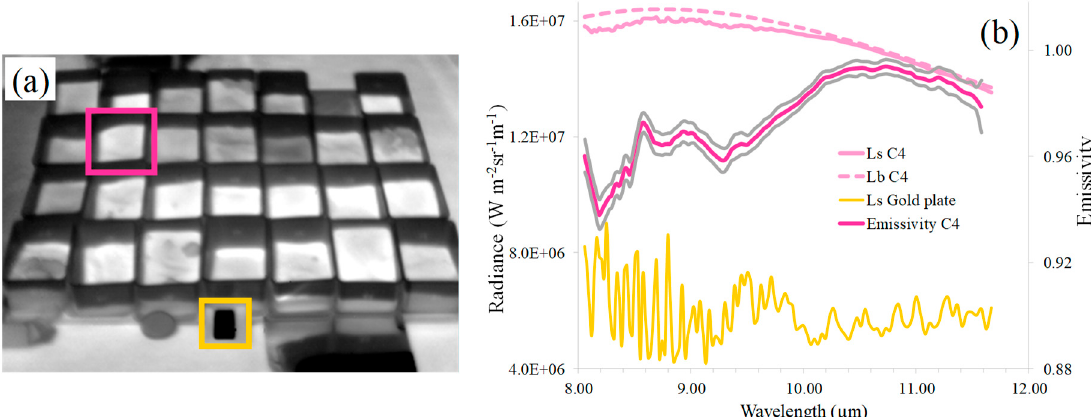
Figure 1. ( a ) Longwave infrared (LWIR) image (band 10.62 µm) of soil samples (each placed in a 17 × 17 × 22 cm box); soil C4 (pink square), and gold plate (yellow square). ( b ) At-sensor radiance (solid pink curve) and fitted tangent blackbody radiation (dashed pink curve) of soil C4, at-sensor radiance of gold plate (yellow curve) representing the downwelling radiance (left y -axis), calculated emissivity of soil C4 (right y -axis) with the respective ± standard deviation curves (gray). Each spectrum is the average of tens of pixels in the image.